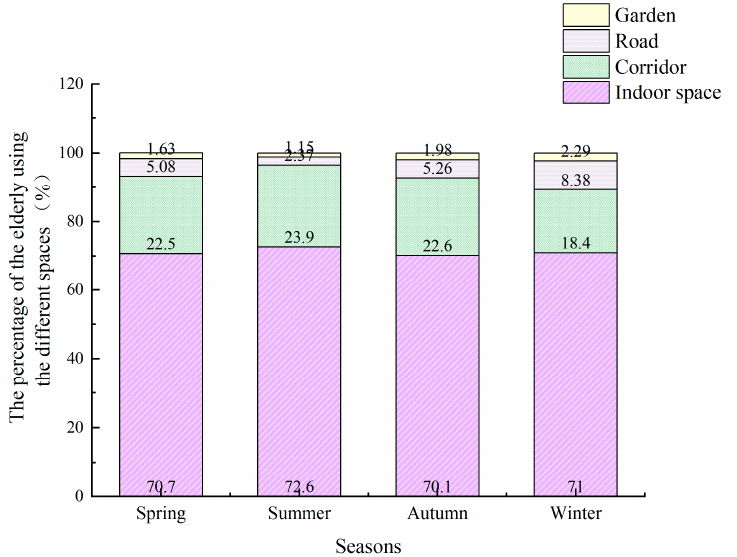
Figure 4. The seasonal usage patterns of indoor and outdoor spaces by the elderly.